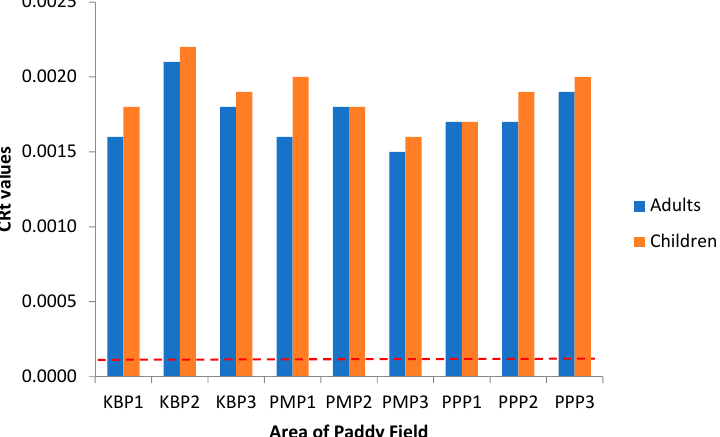
Figure 12. The total cancer risk (CRt) for adults and children via intake of rice from the different sampling sites in Kelantan. KBP1: Kota Bharu Plot 1, KBP2: Kota Bharu Plot 2, KBP3: Kota Bharu Plot 3, PMP1: Pasir Mas Plot 1, PMP2: Pasir Mas Plot 2, PMP3: Pasir Mas Plot 3, PPP1: Pasir Puteh Plot 1, PPP2: Pasir Puteh Plot 2, and PPP3: Pasir Puteh Plot 3.